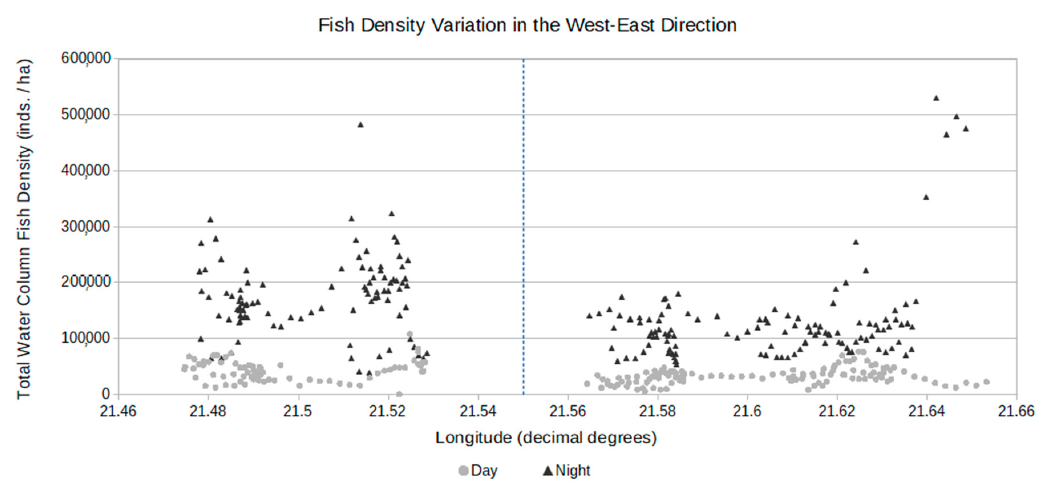
Figure 6. Total water column fish density vs. longitude of averaged-cell midpoint. Significantly 6 di ff erent fish density clusters are visible between the regions for both day and night.